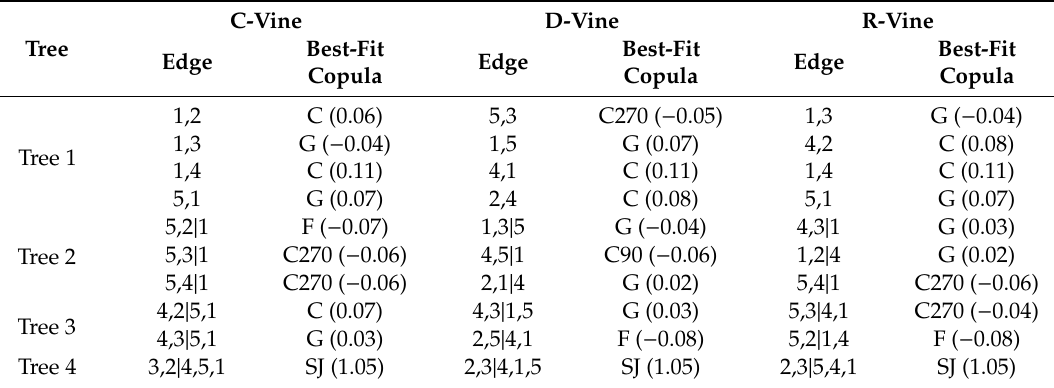
Table 4. The breakdown structures and best-fit copula families of three classes of vines in the period of